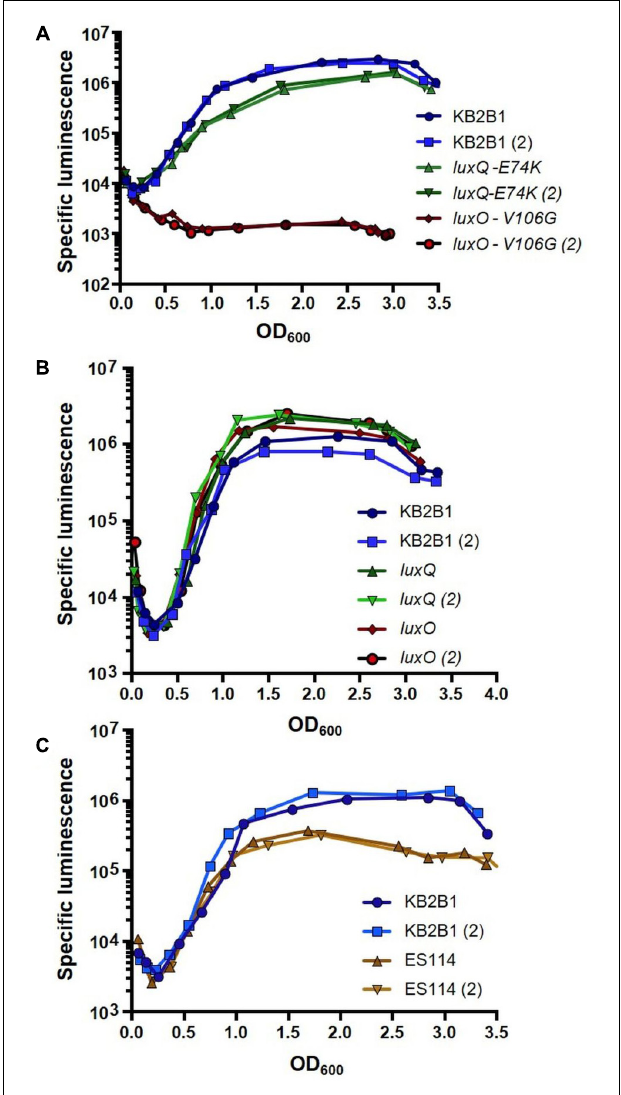
FIGURE 4 | Luminescence of Vibrio fischeri wild-type and lux mutant strains. Shown are the levels of specific luminescence (relative light units divided by optical density) graphed vs. optical density (OD 600 ). (A) KB2B1 and motility suppressor mutants KV8961 (LuxQ-E74K) and KV8964 (LuxO-V106G). (B) KB2B1 and lux null mutants KV9020 ( luxQ ) and KV9019 ( luxO ). (C) KB2B1 and ES114. Experiments were performed with duplicate